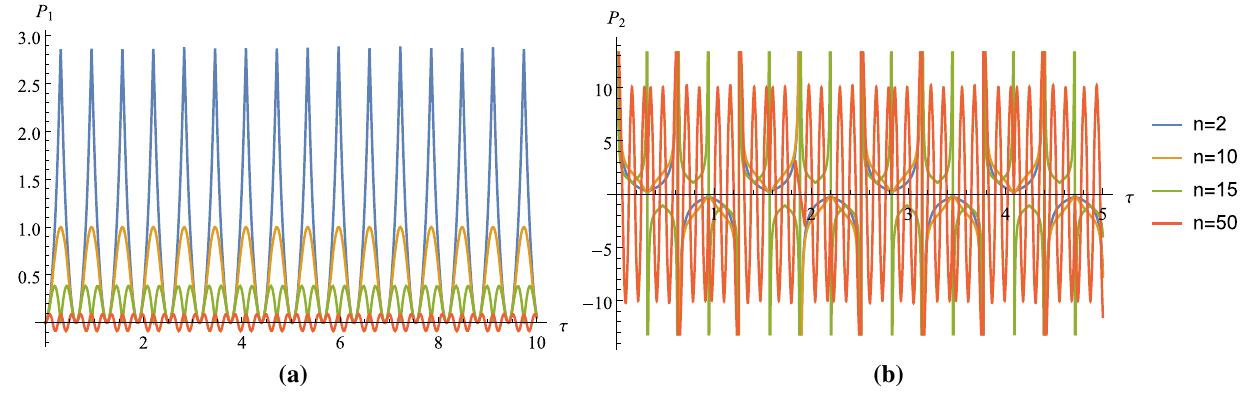
Fig. 1 Perturbations for m = 5, E = 0 .